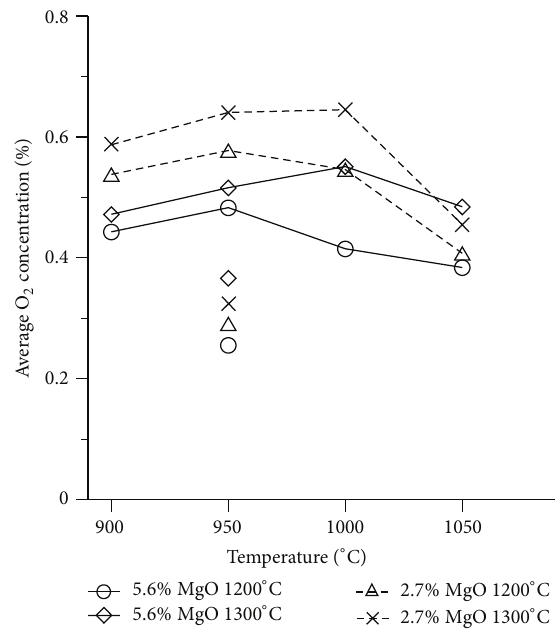
Figure 12: Released gaseous oxygen concentrations at the end of 360 s inert cycles by 5.6% MgO and 2.7% MgO oxygen carriers at different temperatures. The single dots separated from the lines present the results at 950 ∘ C (2)